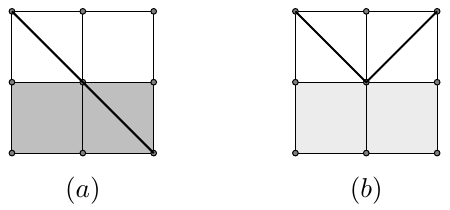
Figure 3 . The two cases where we assign the weight c i = y i to the middle point located at position i . Scanning from left to right, (a) the path enters the ground-state (shaded) band from the top at the middle point, (b) the path makes a valley at the middle point in a non-ground-state (white) band. The lightly-shaded band (the lower band in (cid:12)gure (b)) can be either a ground-state band or